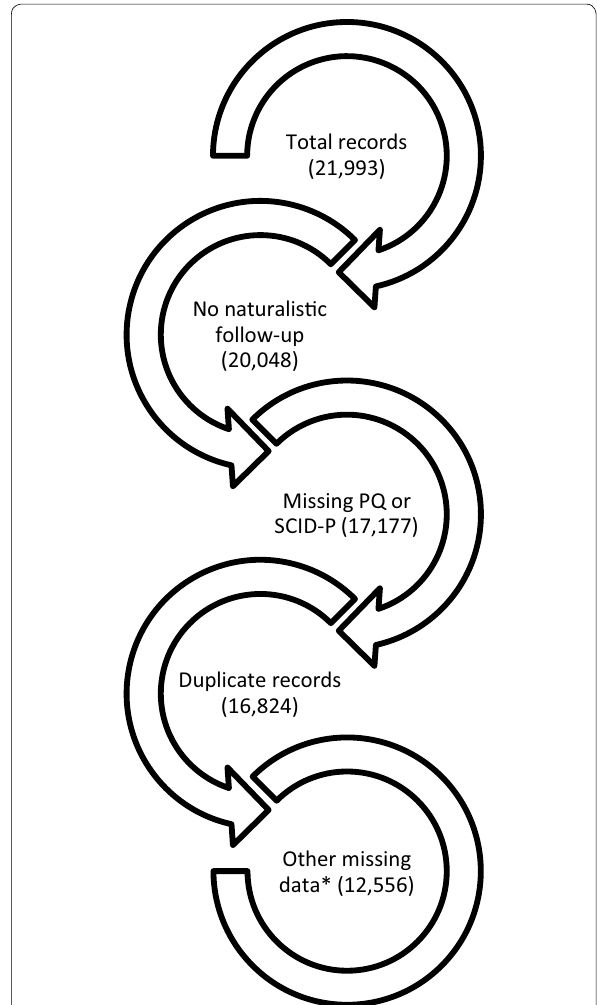
Fig. 1 Flow-chart of exclusion criteria (GAF record number) *No GAF score/inadequate information, no gender, no income, no education, no age at first treatment for mania, no BD type, no AAO, negative duration of untreated